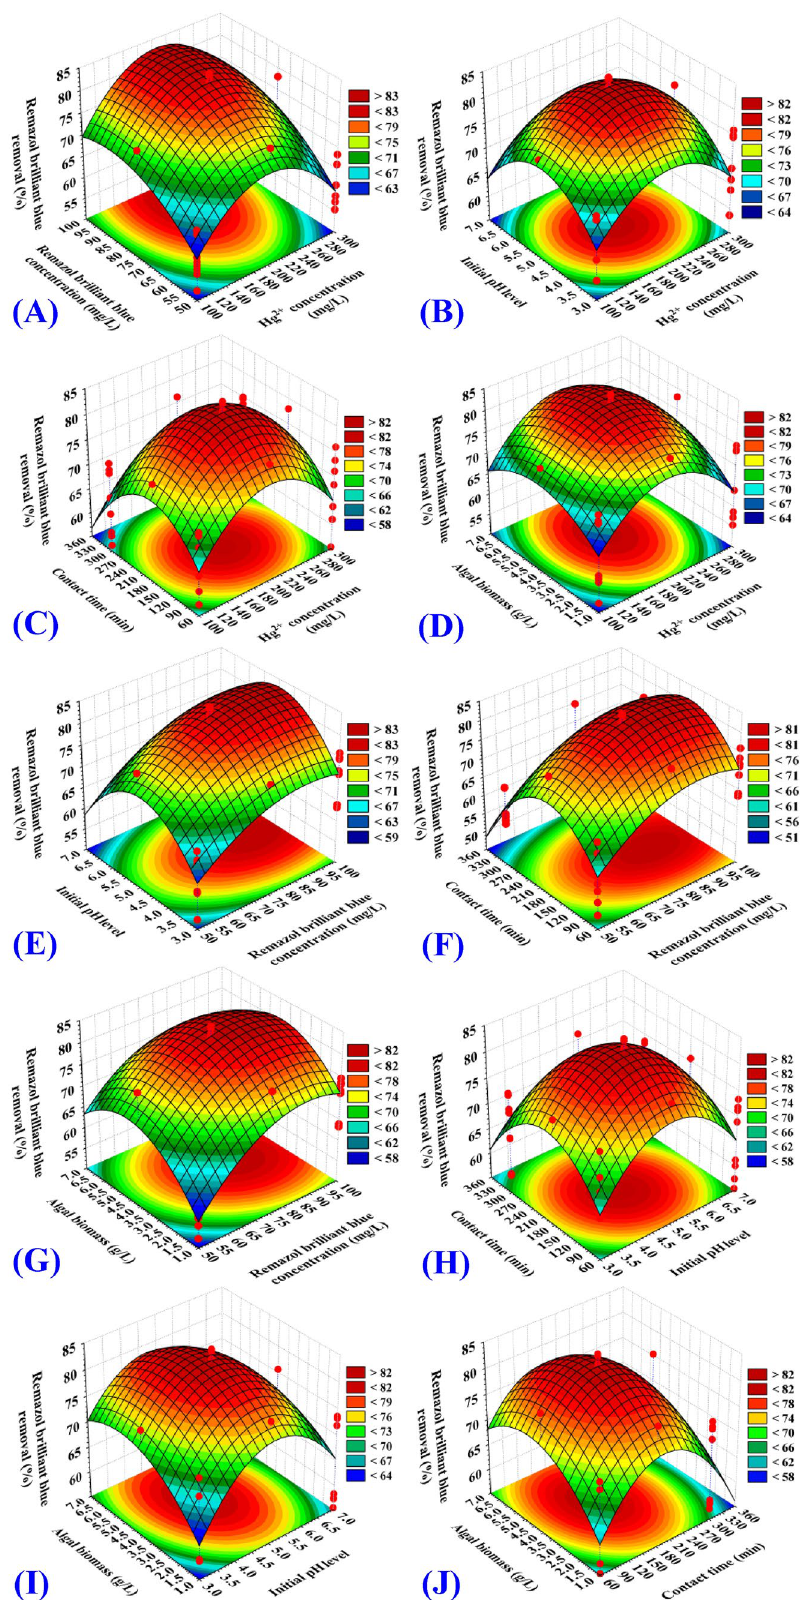
Figure 2. Three-dimensional surface plot for biosorption of Remazol brilliant blue dye by Gelidium corneum biomass, showing the interactive effects of the five tested